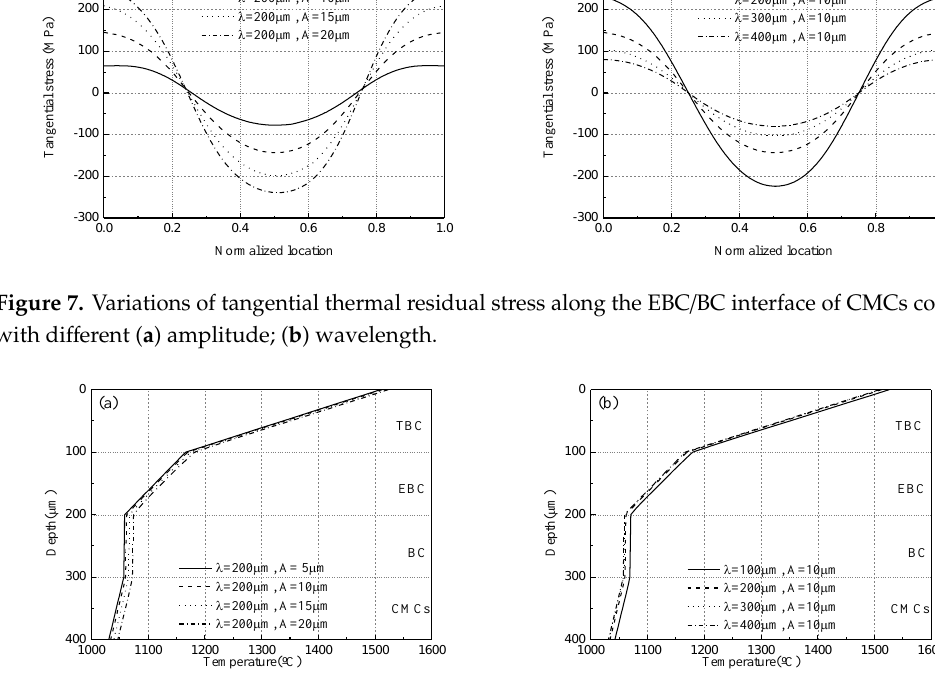
Figure 9. The thermal stress contours of CMCs coating under typical service conditions. Figure 10 shows the variation of Mises stress along the length direction of the TBC surface under typical service conditions of CMCs coating. It can be seen that the minimum Mises stress occurs at the valley while the maximum stress occurs at the peak. Figure 10a shows the influence of the amplitude of surface roughness on the thermal stress distribution. For the same wavelength, the larger the amplitude is, the larger magnitude and range the Mises stress are. The maximum Mises stress on TBC surface increases from 190 MPa for A = 5 μm to 280 MPa at A = 20 μm when λ = 200 μm.